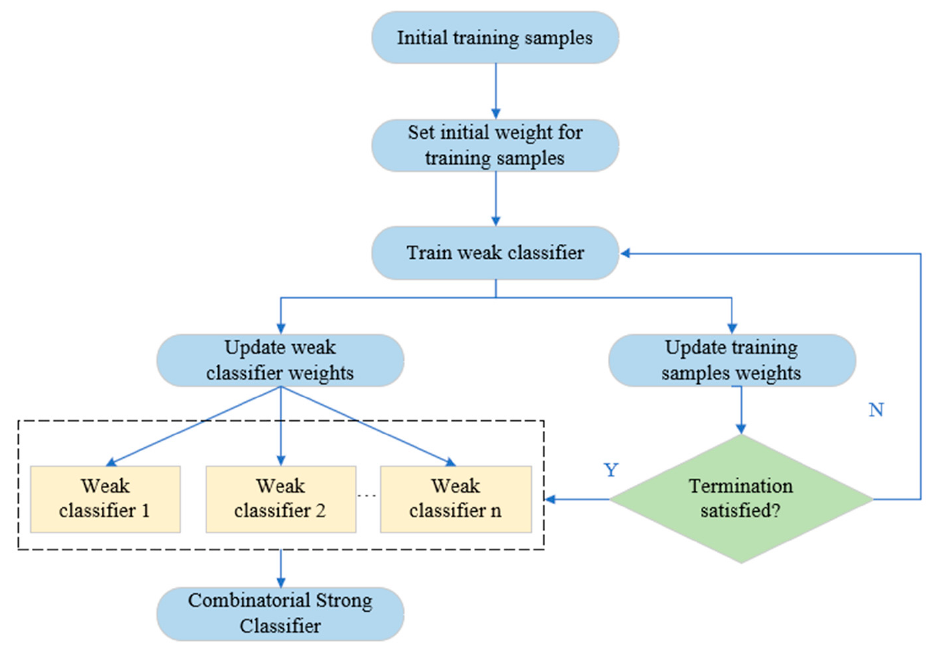
Figure 4. Framework of AdaBoost ensemble model.